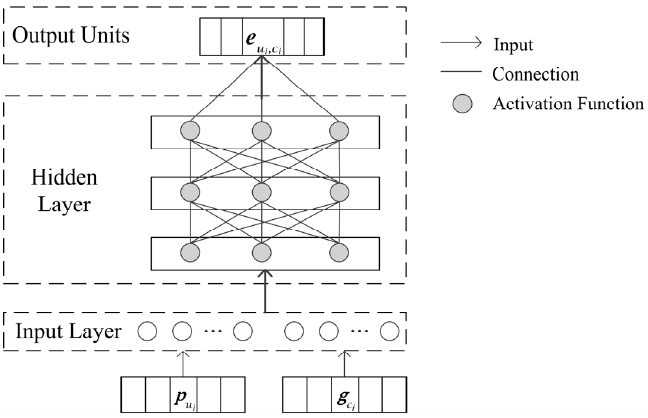
Figure 2. The Structure of Context Interaction Layer Module.